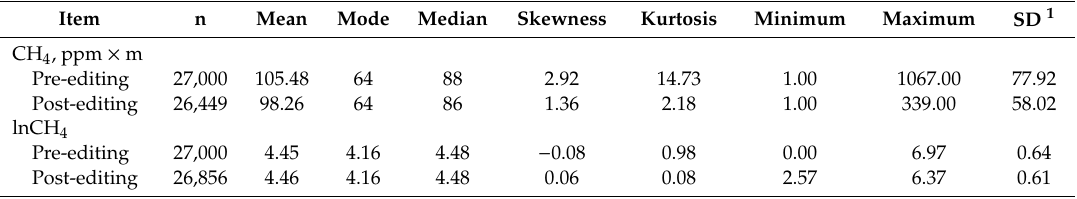
Table 1. Descriptive statistics of methane (CH 4 ) and log e -transformed methane (lnCH 4 )